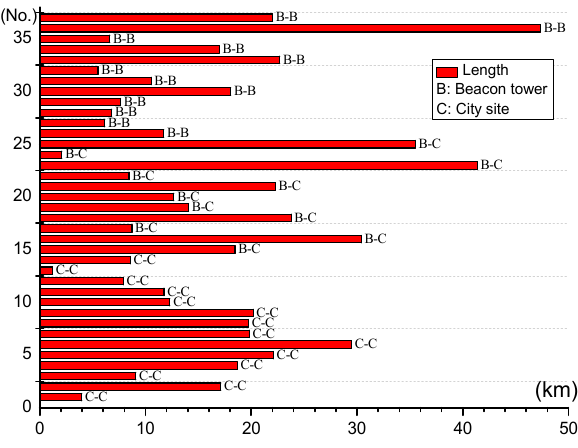
Figure 8. Length of visibility lines. The observing sites are classified into three observing types.